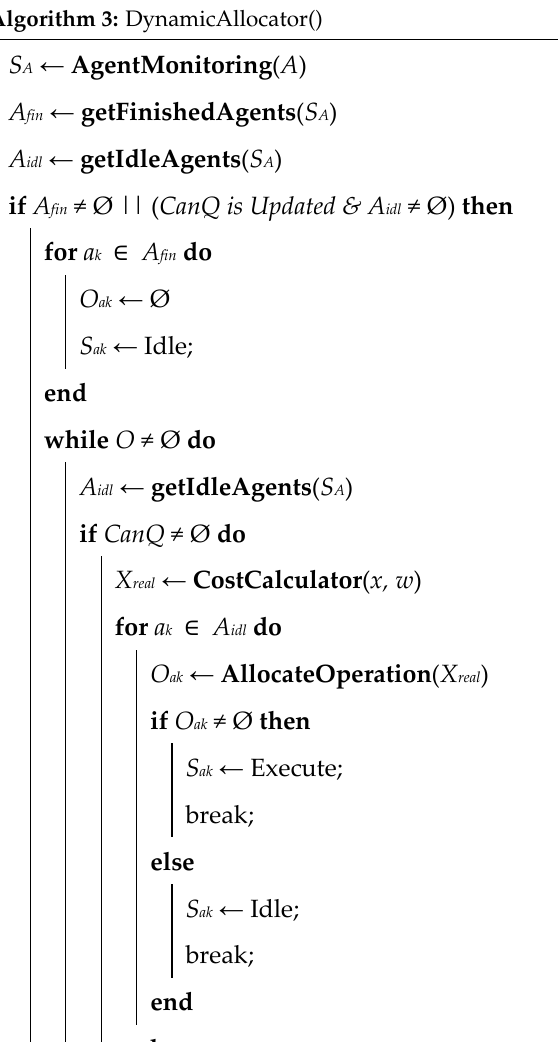
Algorithm 3: DynamicAllocator()